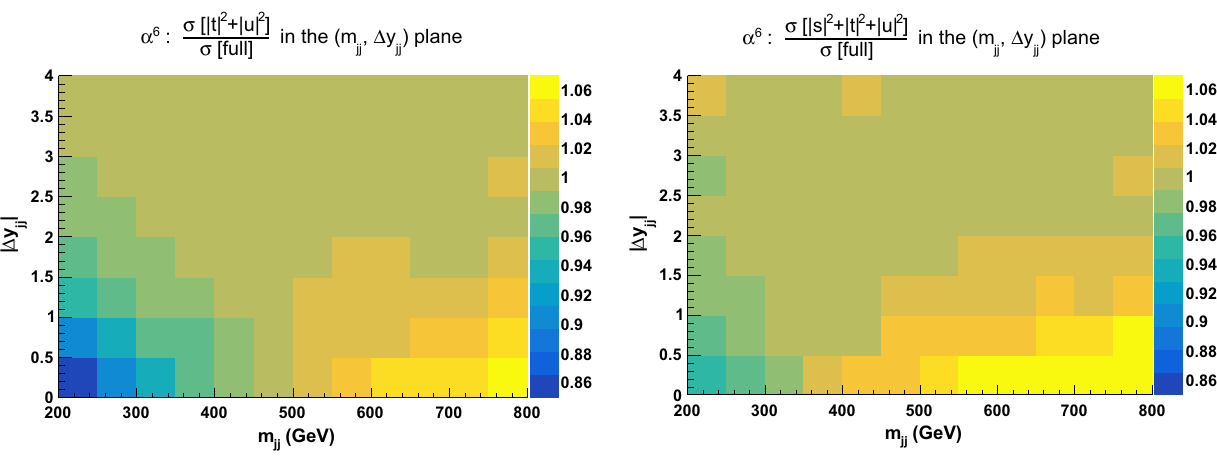
computed as | A | 2 ∼ | t | 2 + | u | 2 (left) and | A | 2 ∼ | s | 2 + | t | 2 + | u | 2 (right). The cuts applied are the ones of Sect. 3.3 and no cuts on m jj and | Δ y | are jj